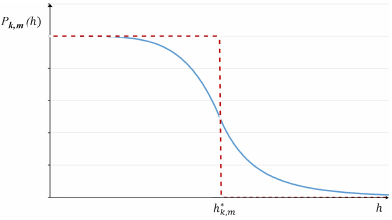
Figure 1. Case m − k (cid:54) = 1: shape of the sigmoid distribution (2.7) (full line) and the two steps corresponding one (2.5) (dashed line), ( P k,m ( h ) ≡ Prob { X ( m ) ( h ) ≤ X ( k ) ( h ) }